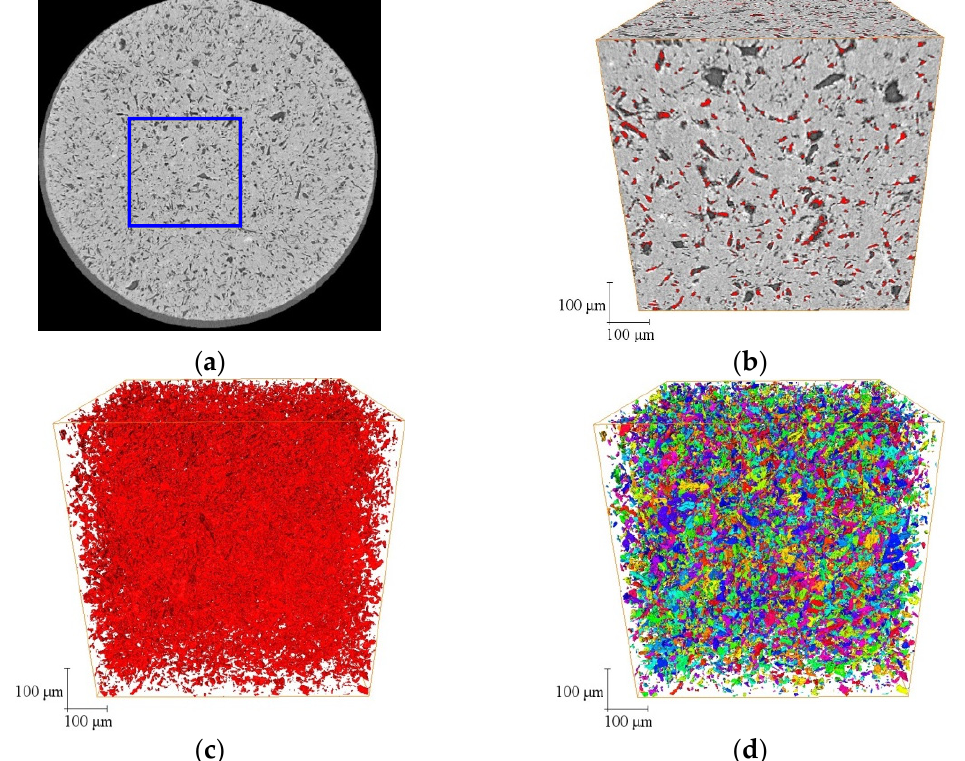
Figure 4. Pore extraction steps using the micro-CT. ( a ) 2D slice; ( b ) 3D reconstruction of pore im age; ( c ) pore distribution; ( d ) connectivity of the pores. In Figure 4d, each color signals a pore not connected to the others.